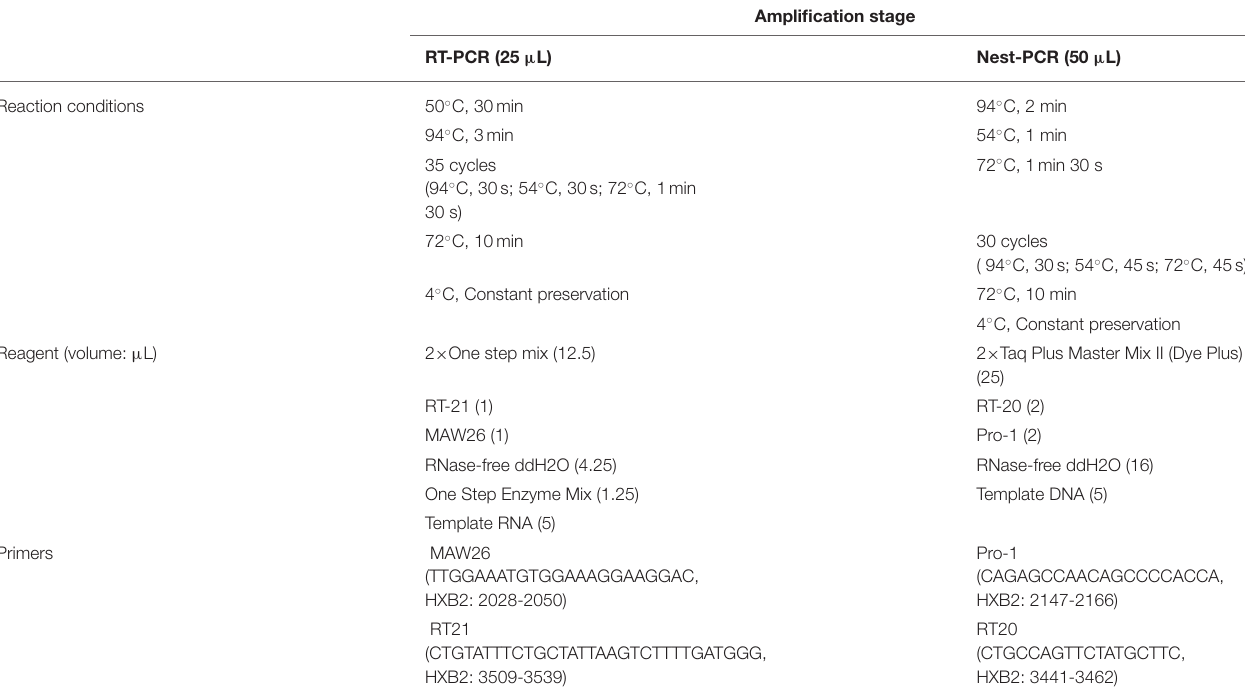
TABLE 1 | Amplification system of Pol